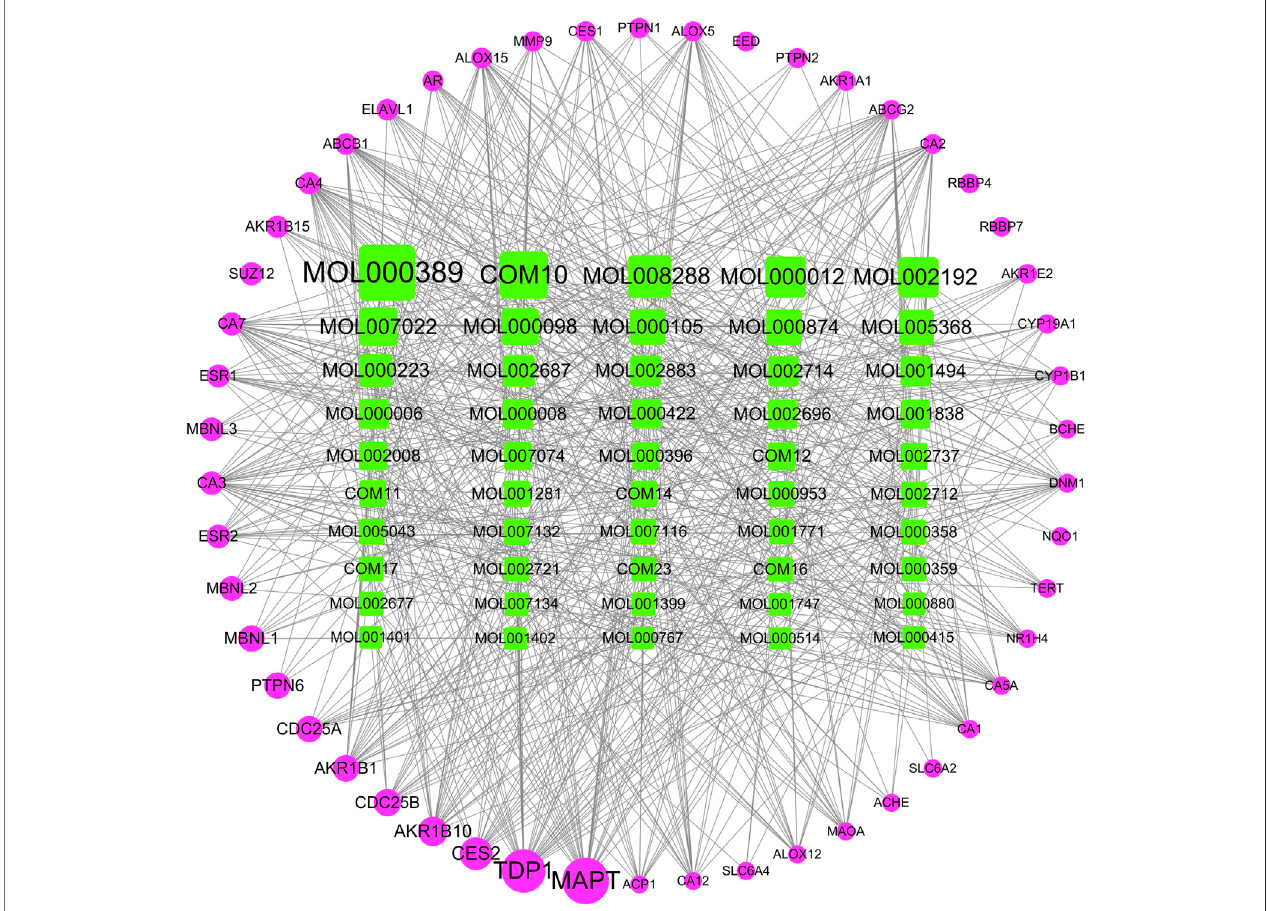
FIGURE 5 | I-T network. The top 50 ingredients and top 50 targets valued by the degree in the I-T network are shown in Figure 5 . Green represents potentially active ingredients, pink represents targets; node size represents the importance of the genes in the network.